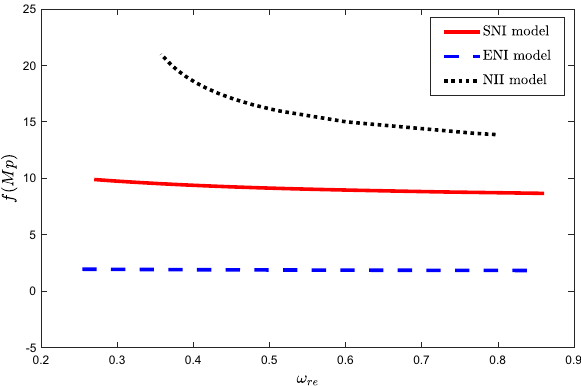
Fig. 9 Feasible parameter space comparison of SNI, ENI, and NII models under CMB and reheating